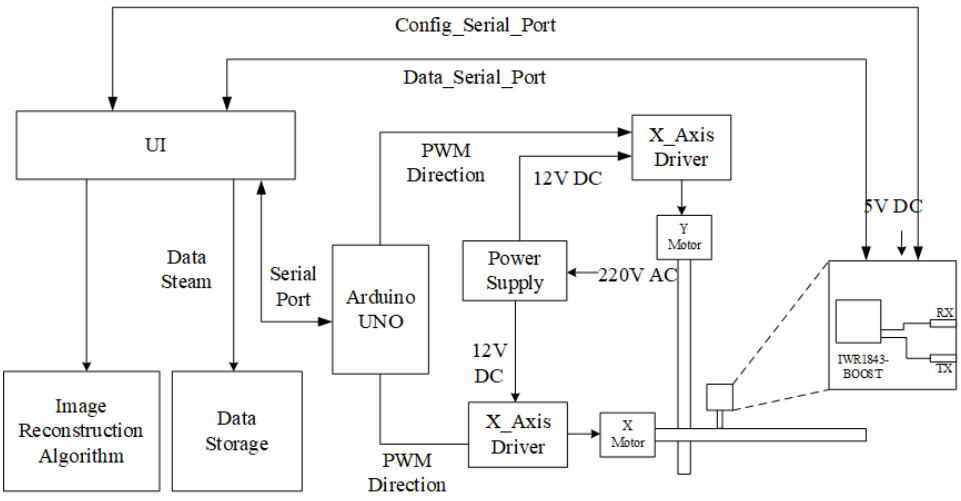
Figure 10. The architecture of the SAR testbed consists of a mmWave sensor and a mechanical